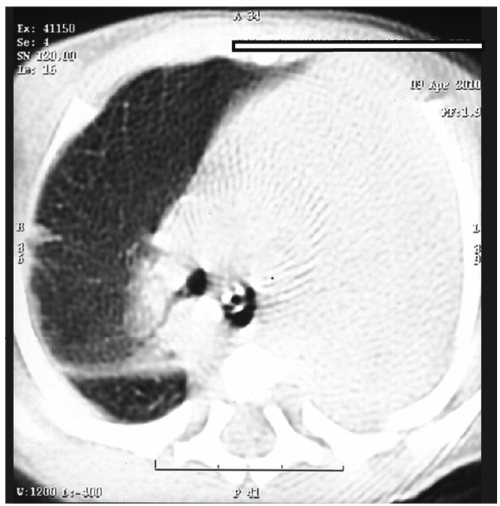
Figure 3: CT chest with atretic left hemithorax.